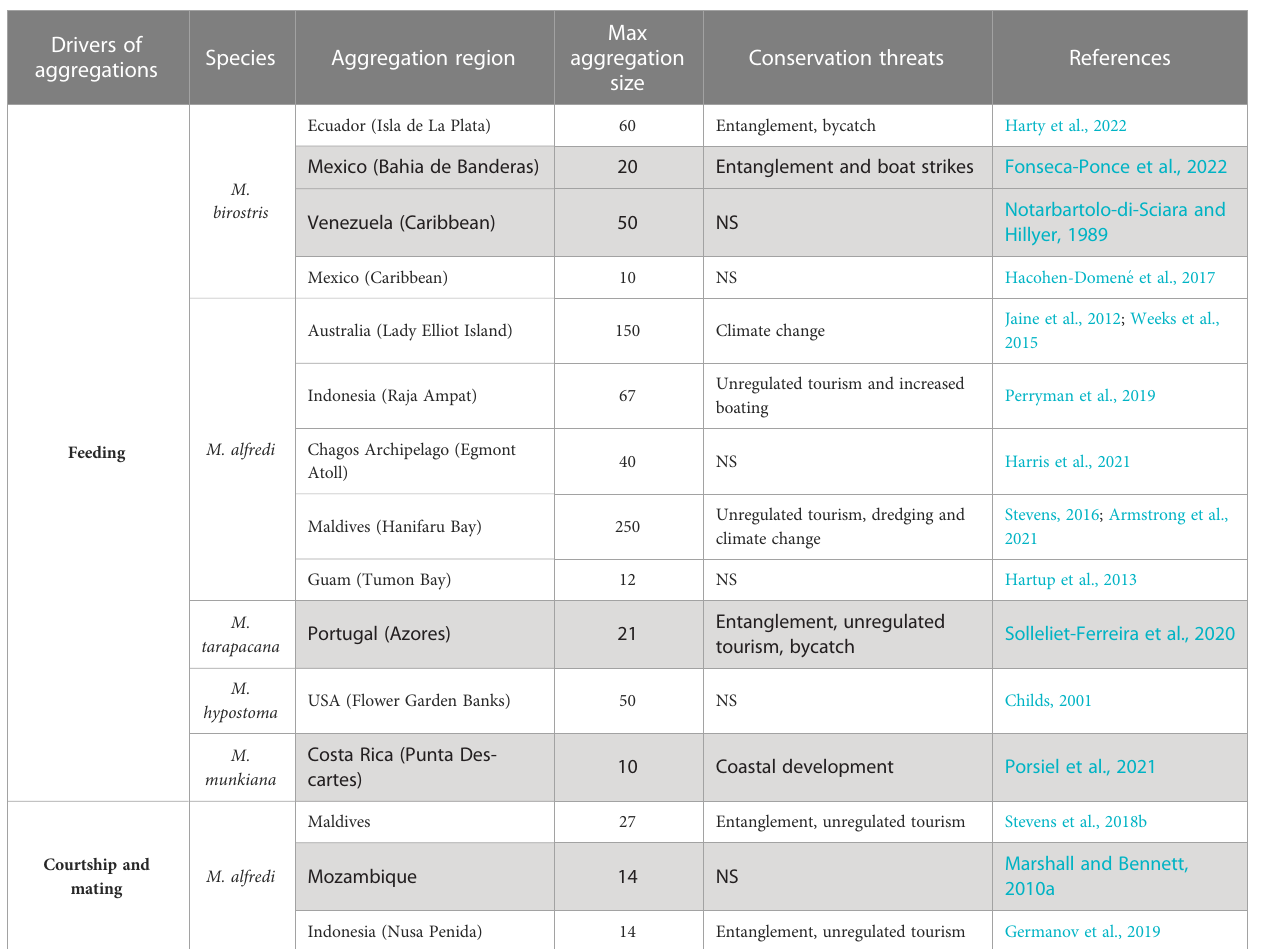
TABLE 2 Types of aggregations and social groups based on drivers of the groups for manta and devil rays.